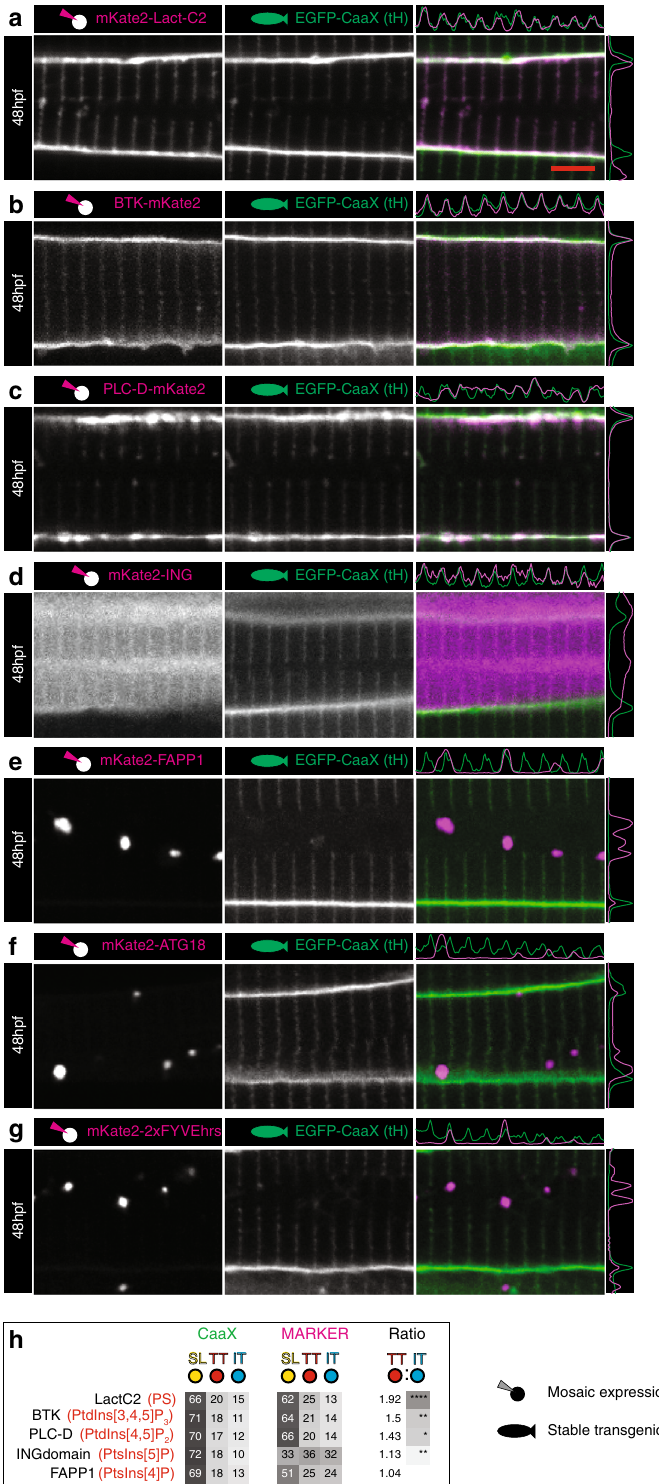
Fig. 7 Phosphoinositide signature of early T-tubules. a LactC2 probe for phosphatidylserine (PS). b BTK probe for PtdIns(3,4,5)P 2 . c PLC-D probe for PtdIns(4,5)P 2 . d ING probe for PtdIns(5)P. e FAPP1 probe for PtdIns(4)P. f ATG18 probe for PtdIns (3,5)P 2 . g 2xFYVEhrs probe for PtdIns(3)P. h Ranked heatmap comparing average pixel intensity across each domain (T-tubule, sarcolemma and inter-T-tubule domain), for markers of interest and EGFP-CaaX. n = 6 fi bres per marker, each from individual biologically independent animals per condition, measured over one independent experiment. Two-tailed T- test. * p < 0.05, ** p < 0.01, *** p < 0.001, **** p < 0.0001. Exact p values are given in source data. Scale bars, 5 µ m. All images are representative of 12 individual cells within different individual